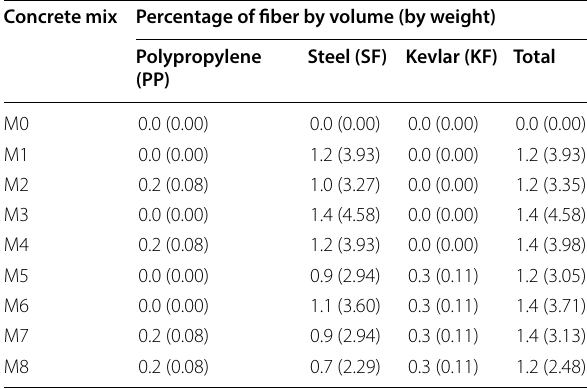
Table 3 Fiber percent in different concrete mixes.